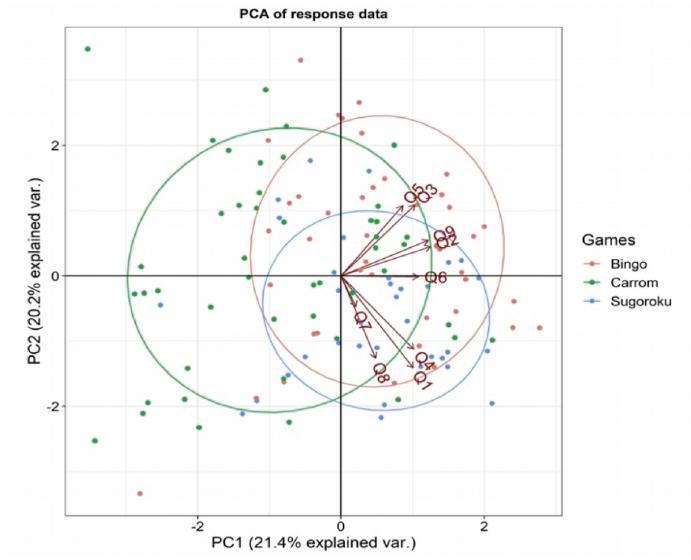
Figure 4. A bi-plot showing placement of responses from the participants as per the PCA components with respect to different questions after playing the games. Space components close to each other share similar